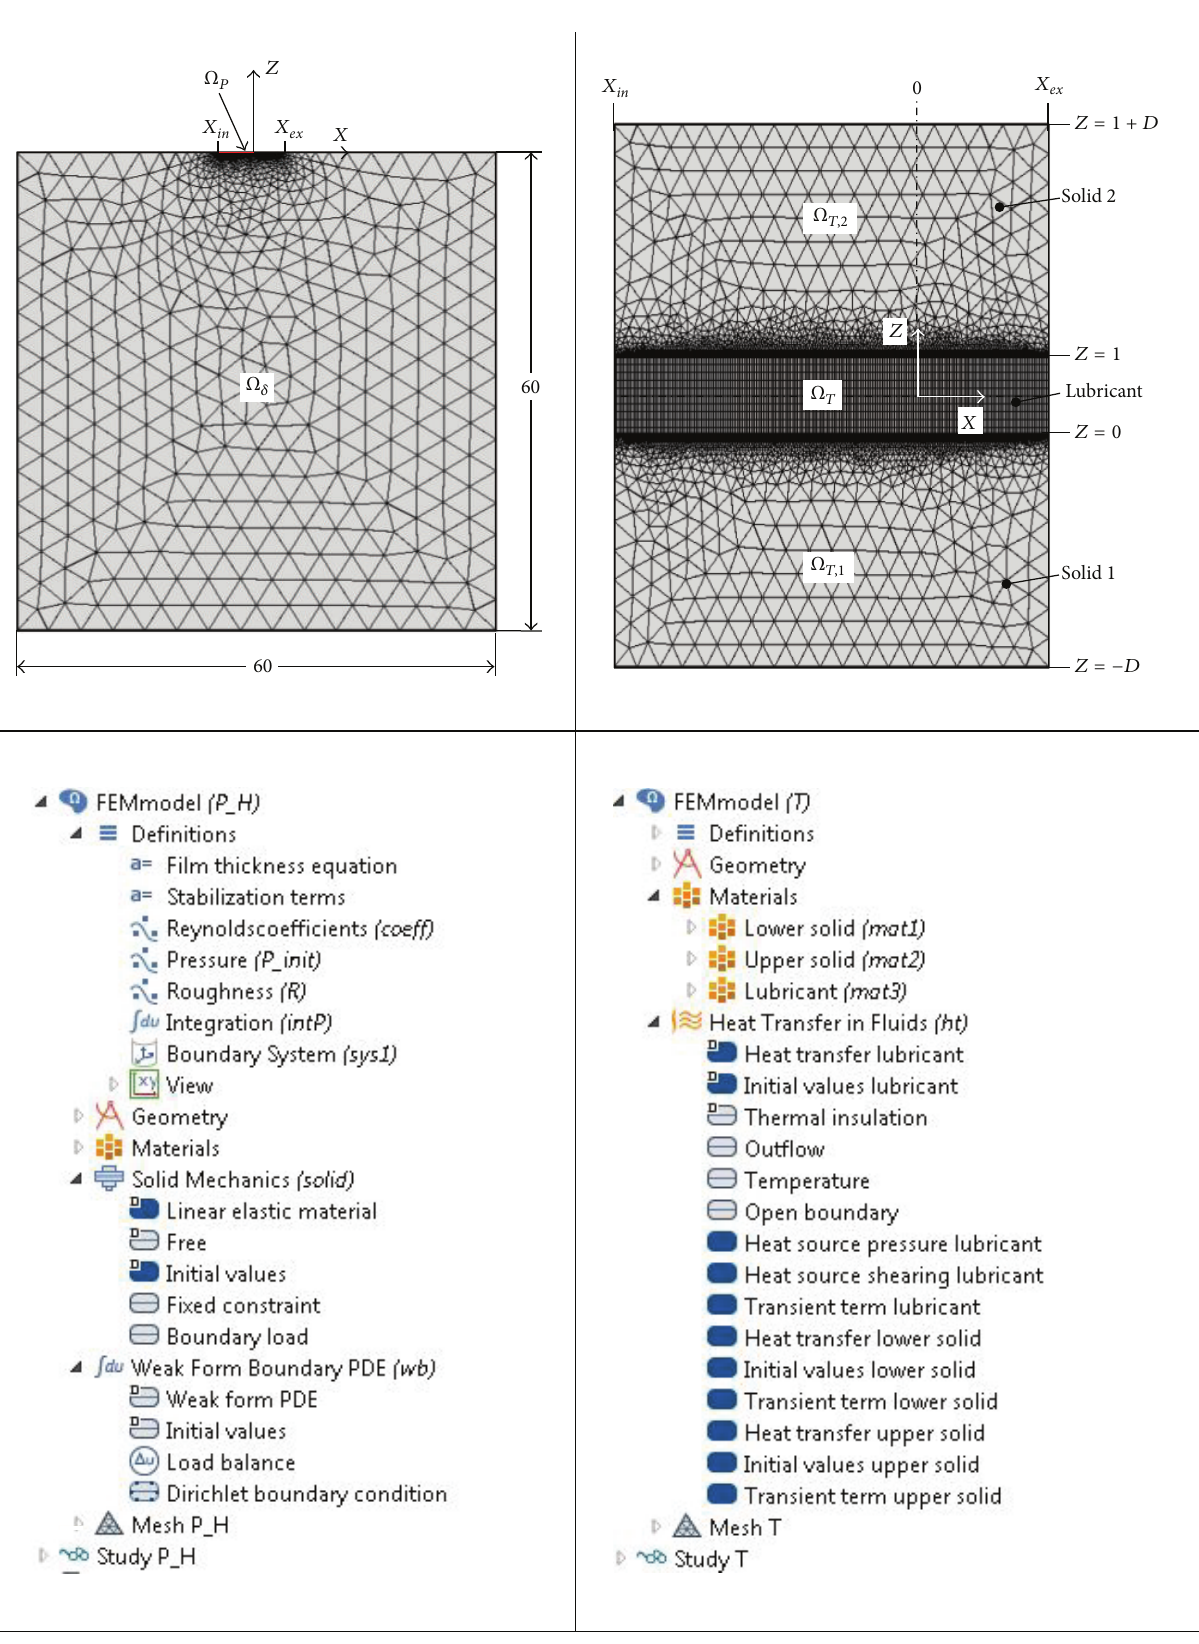
Figure 3: FEM-model ( 𝑃,𝐻 ) for pressure and film thickness calculation with corresponding COMSOL model tree (left) and FEM-model ( 𝑇 ) for temperature calculation with corresponding COMSOL model tree (right); element numbers are adjusted for presentation